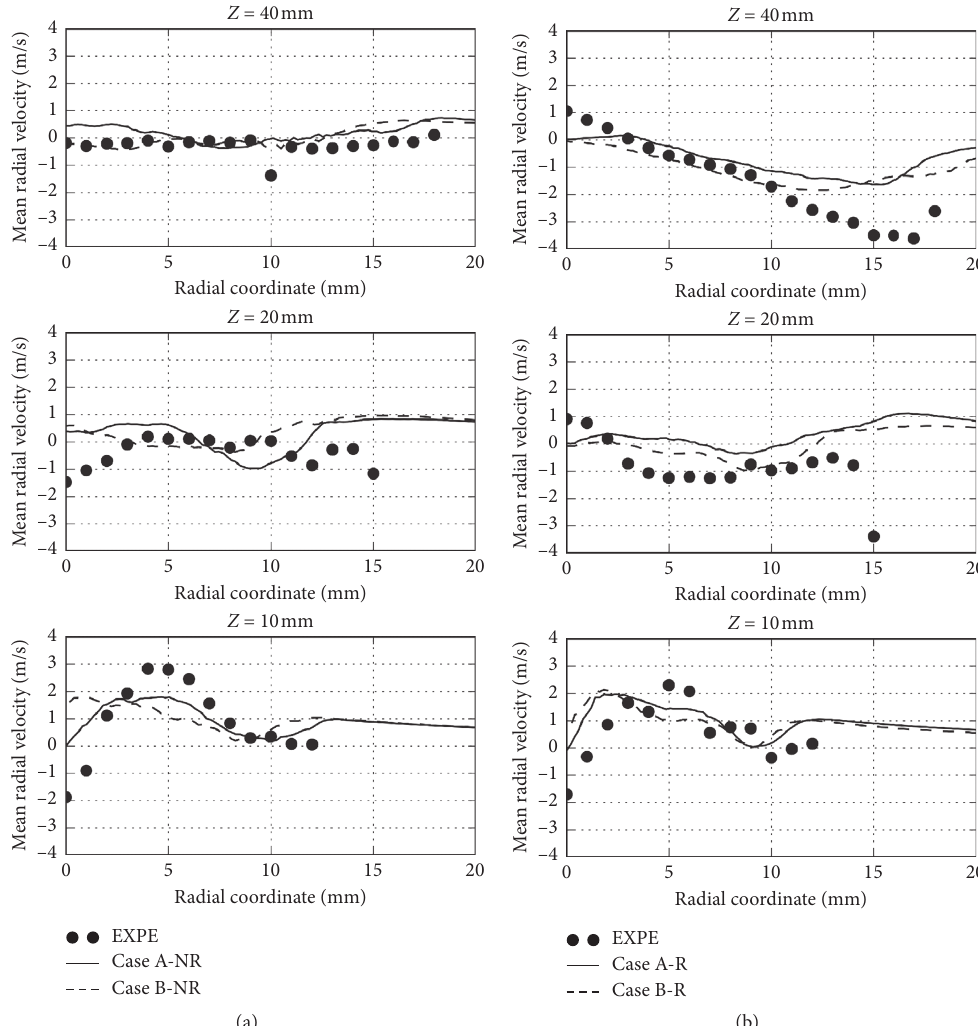
Figure 12: Radial profiles of mean radial velocity for nonreacting (a) and reacting case (b). Symbols: experiments, solid line: case A dashed line: case